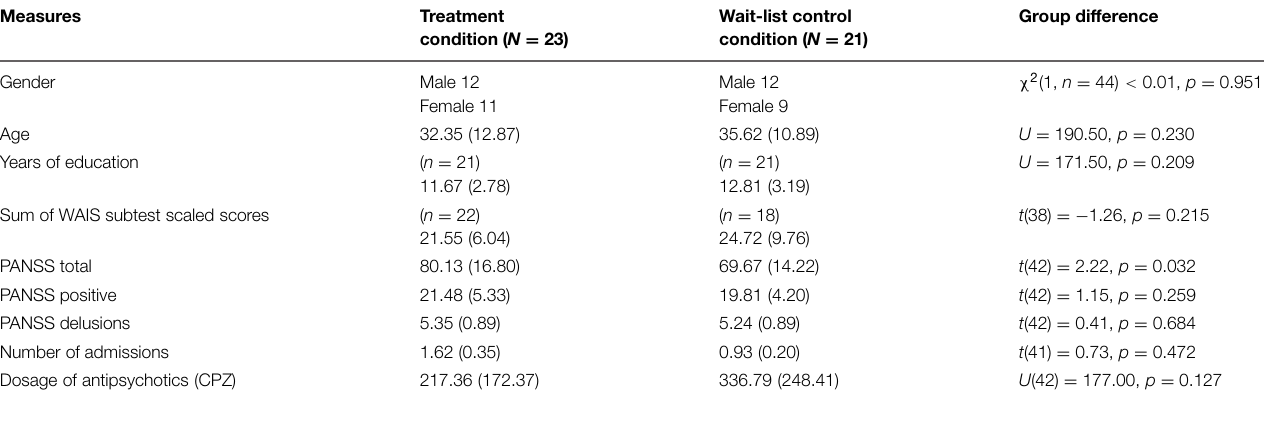
TABLE 1 | Demographic and clinical variables at